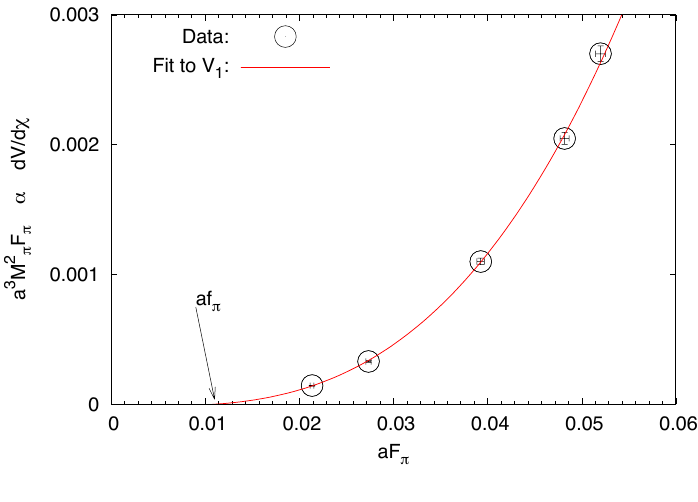
Figure 2 . Lattice data for the product M 2 F (cid:25) (proportional to the slope of the scalar potential at (cid:25) (cid:31) = F d ) versus F (cid:25) (proportional to F d .) The red line represents a (cid:12)t to eq. (3.10) which derives from the potential V 1 . The lattice spacing is denoted by the parameter